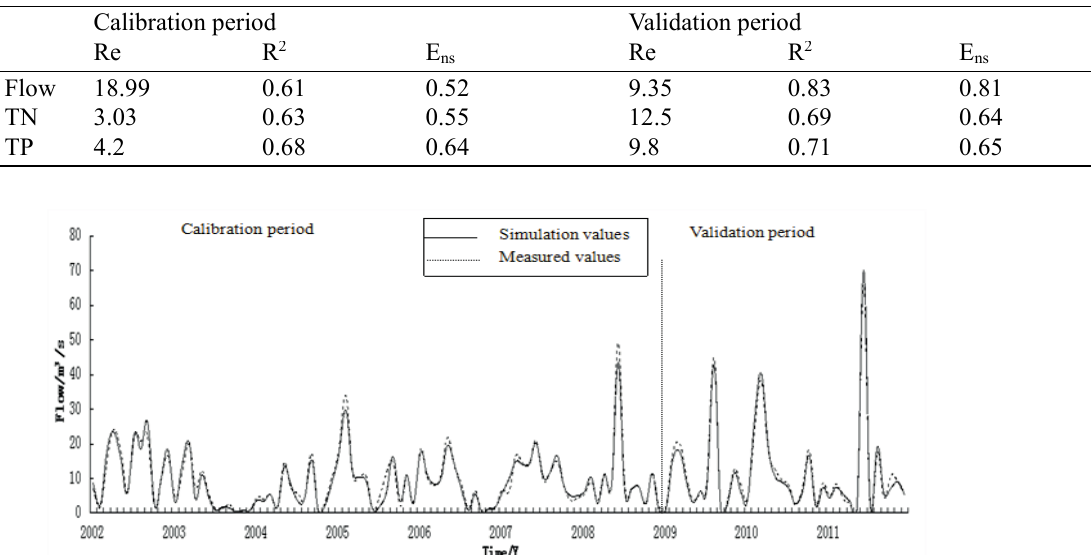
Table 3 Results: TN is total nitrogen; TP is total phosphorus.